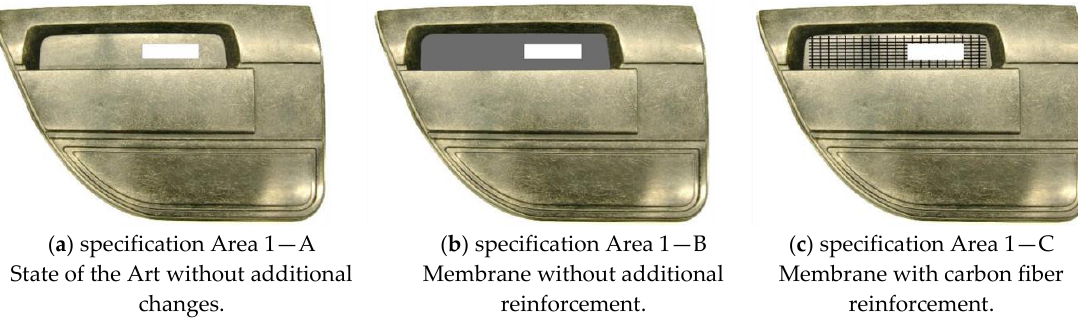
Figure 8. Definition of three different manufacture specifications of the door panel. ( a ) represents a structure without additional changes, ( b ) without any reinforcement, and ( c ) a structure with carbon fiber reinforcement.